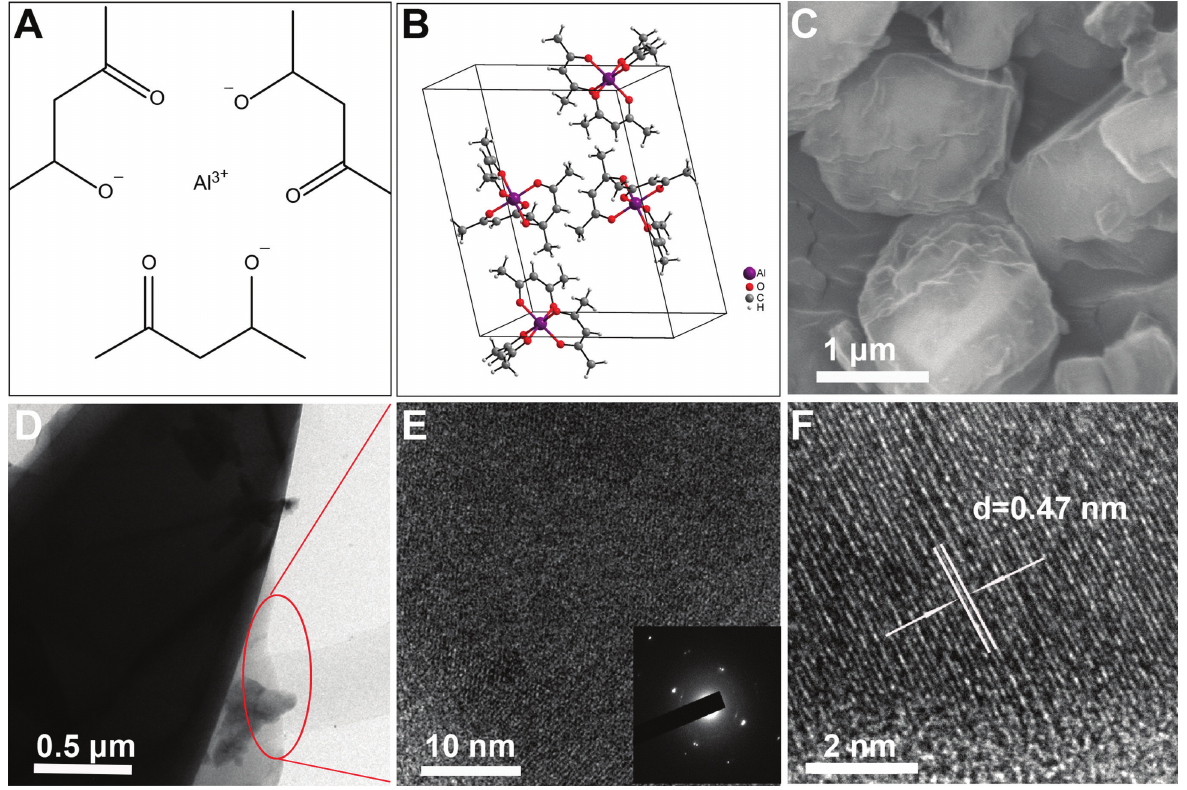
precursor and S1. 3 precursor crystals. (C) High-resolution SEM image of Al(acac) 3 precursor, the inset in the HRTEM image displays FFT 3